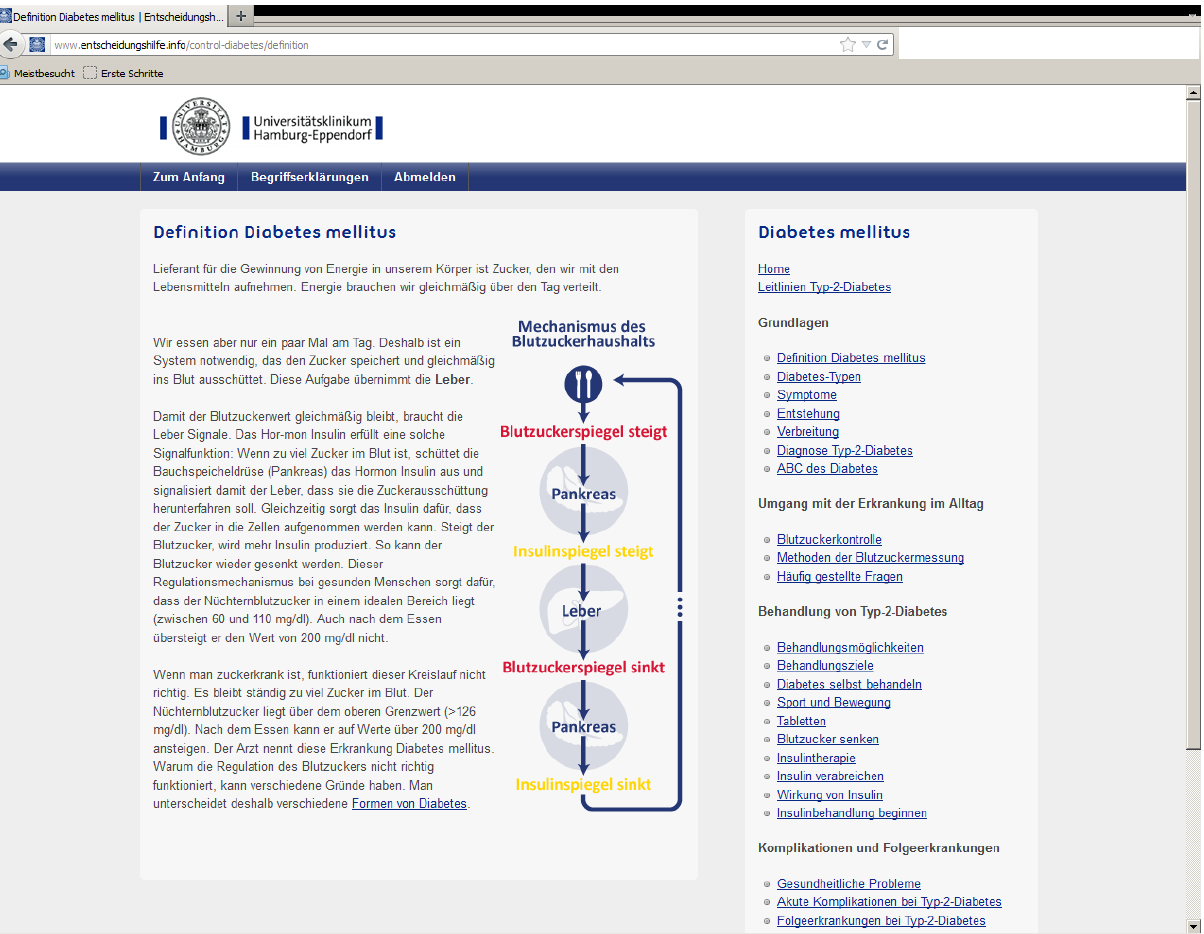
Figure 2. Control